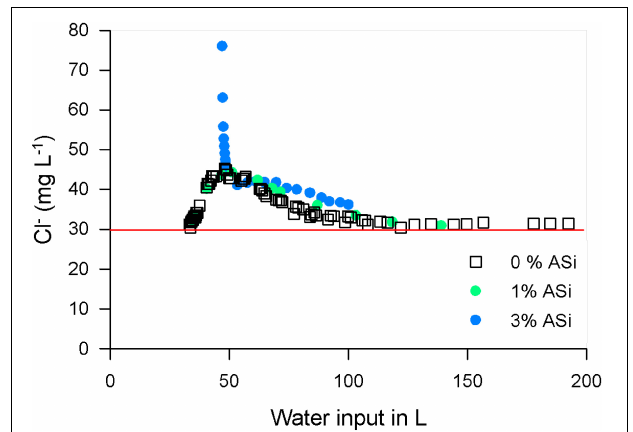
FIGURE 8 | Chloride (Cl - ) concentration in the seepage water in relation to water input for different soil ASi content. The red line indicates the concentration of the irrigation